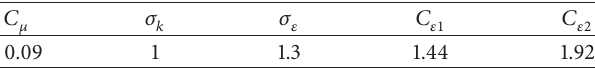
Table 1: Coefficients for standard 𝑘 - 𝜀 turbulent model.